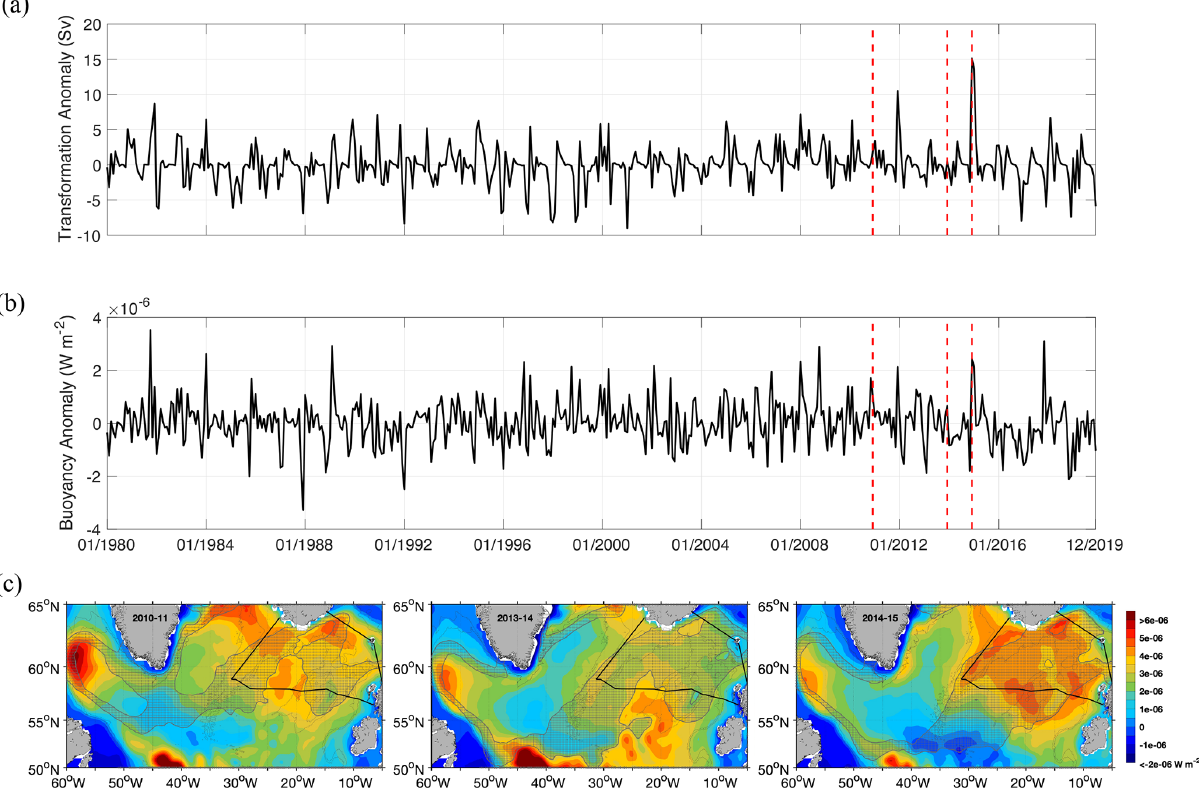
Figure 6. (a) Transformation anomaly at the SPMW isopycnal 27.4kgm − 3 between 1980 and 2019, as estimated in Eq. (1). (b) Buoyancy flux anomaly over the Iceland Basin between 1980 and 2019; dashed red lines indicate transformation and buoyancy anomalies in December 2010, 2013 and 2014. (c) Maps of buoyancy forcing superimposed by the surface density area 27.3–27.5kgm − 3 in gray during the winter (December to April) of 3 different